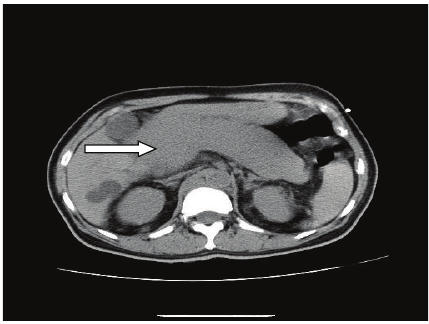
Figure 1: Diffuse enlargement of the pancreas with homogeneous attenuation and without significant peripancreatic inflammation.